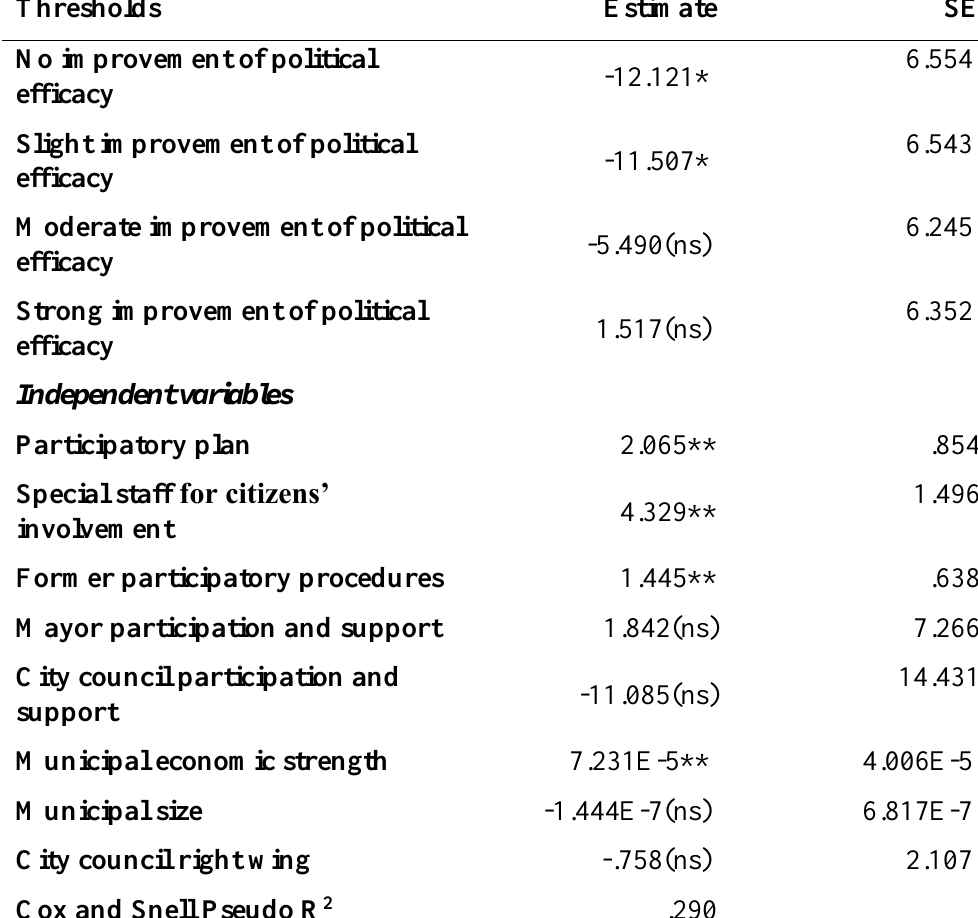
Table 2. Ordinal regression on group-related political efficacy in deliberative procedures